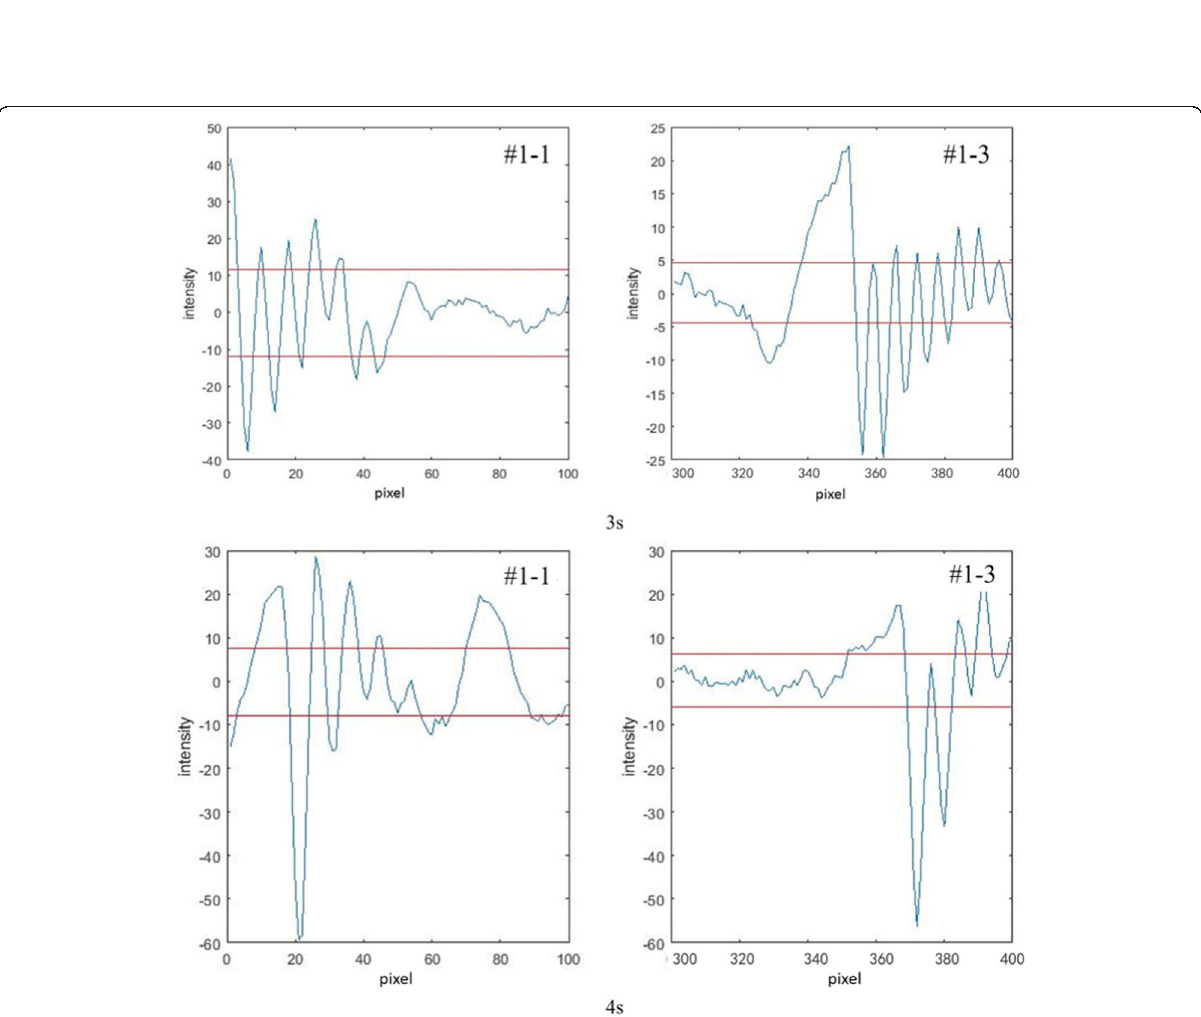
Fig. 12 Intensity distribution of oil films #1 and #3 at t = 3 s and 4 s for baseline case